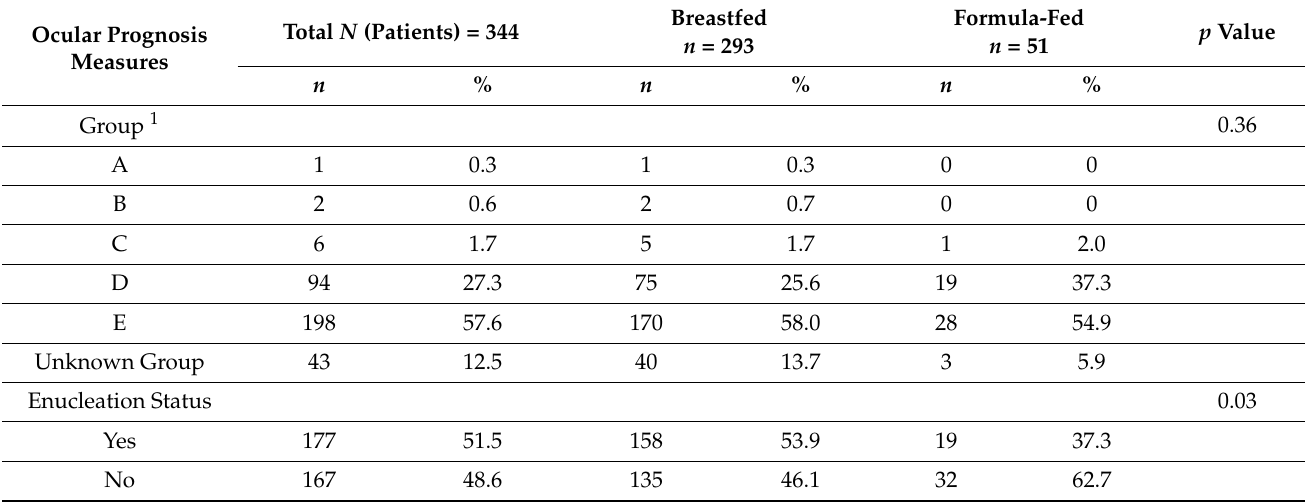
Table 2. Distribution of ocular prognosis measures and breastfeeding status.